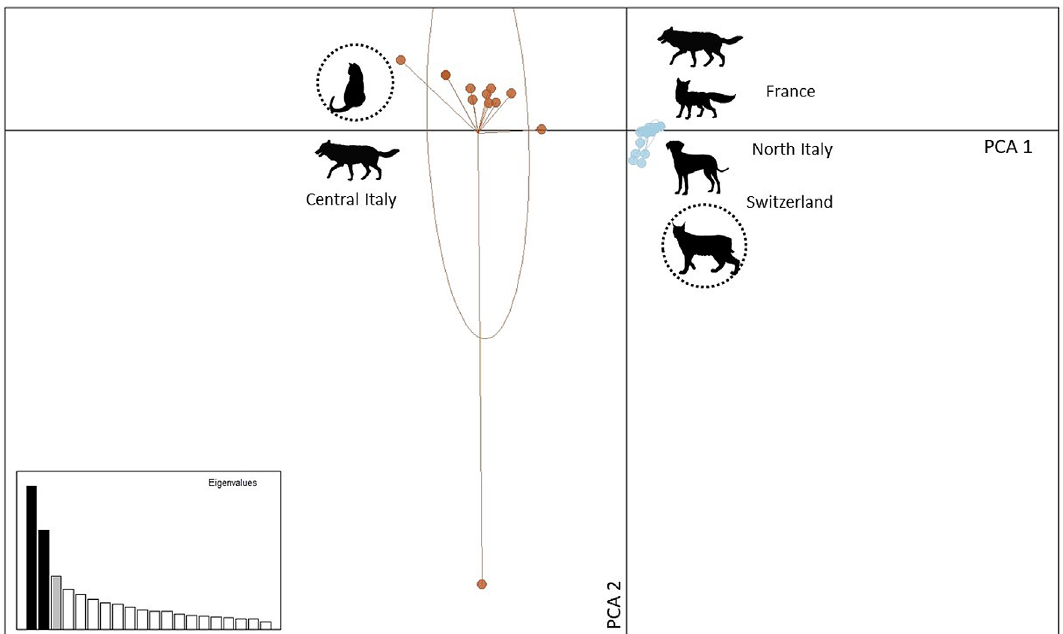
Figure 2. Principal components analysis (PCA) of microsatellite loci representing cat-, dog-, lynx-, wolf- and fox-derived mite populations in France, Switzerland, North Italy and Central Italy. Each population is labelled with the host species and the geographical origin. The eigenvalues of the two axes are displayed in the barplot on the left. Components PCA 1 and PCA 2 explained 11.3% and 7.9% of the variance, respectively (black bars of the eigenvalues,